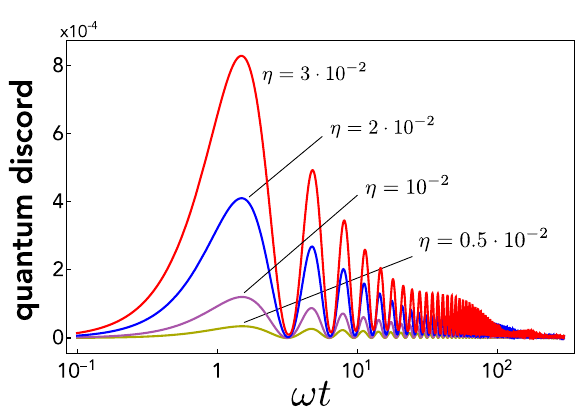
1 ) when each mass starts in a